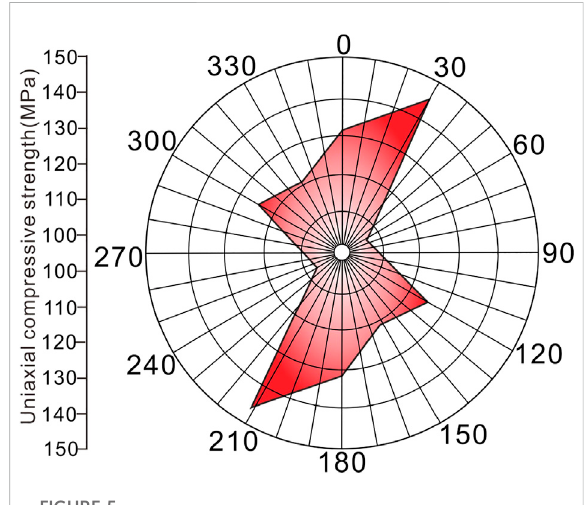
FIGURE 5 Uniaxial compressive strength of the rock in different